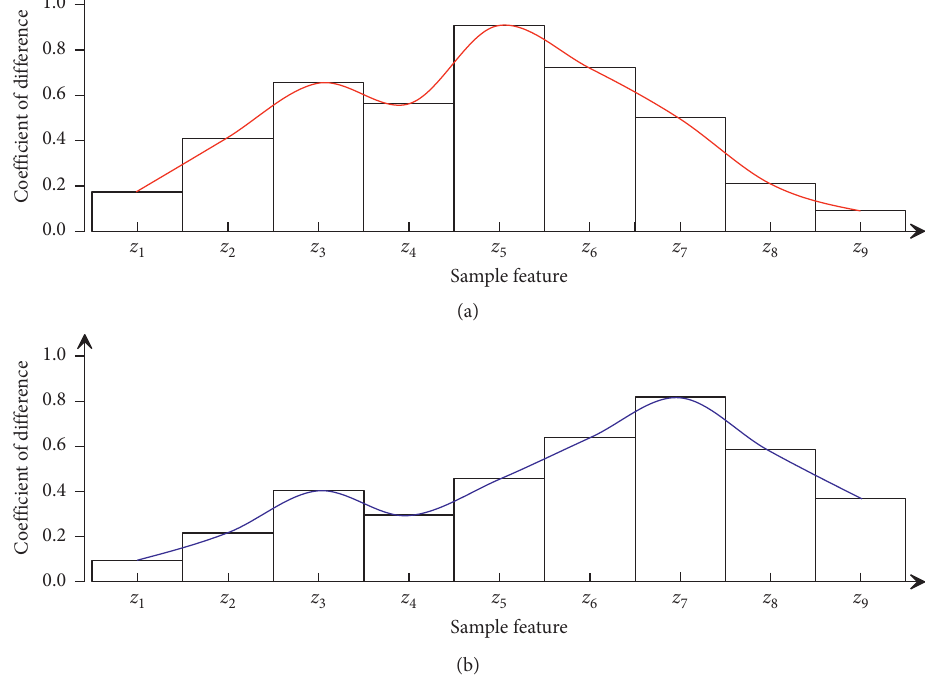
Figure 7: Coefficient of difference of sample feature with neural network (a) and simulated annealing (b)